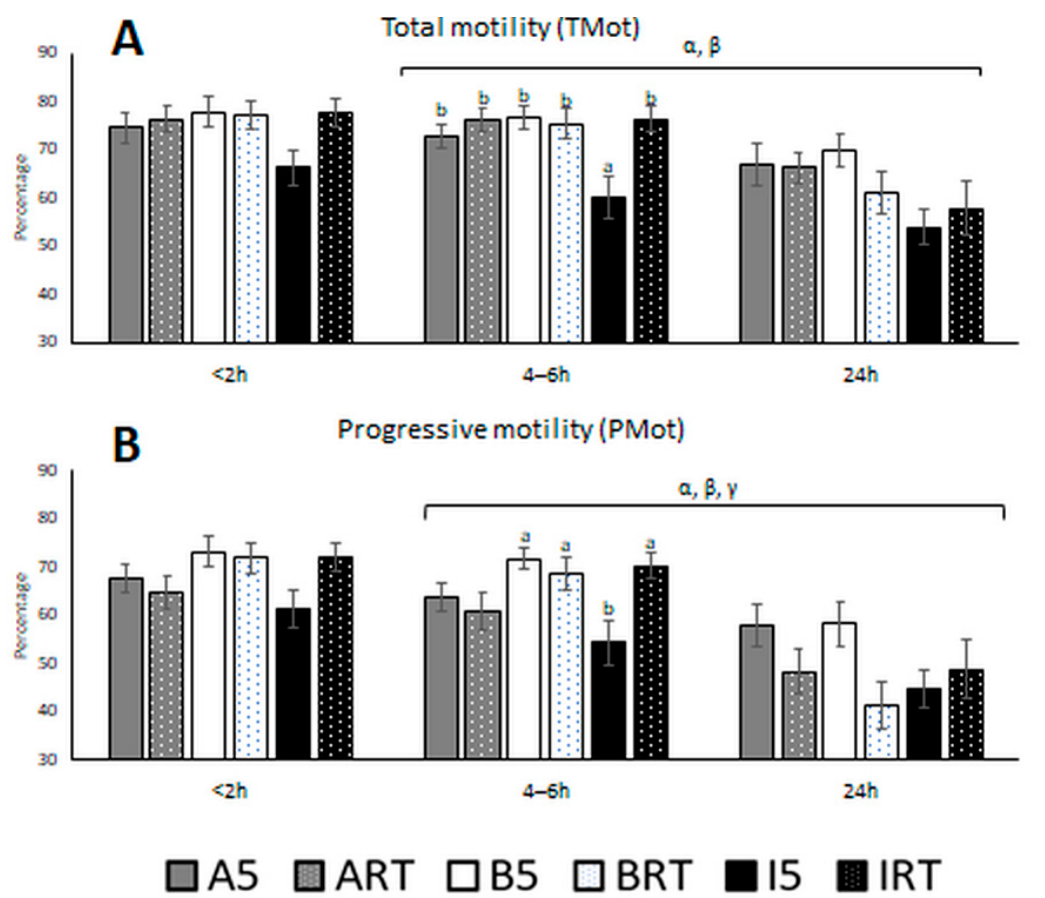
Figure 3. ( A ) Bull sperm total motility (percentage) and ( B ) progressive motility (percentage) after three storage durations in the presence of three semen extenders at two holding temperatures. Aliquot abbreviations: A: AndroMed ® ; B: BIOXcell ® ; I: INRA96 ® ; RT: room temperature; 5: refrigeration at 5 °C. Factors abbreviations: t: time; Temp: temperature; Ex: extender; α : interaction temperature by extender; β : interaction temperature by time; γ : interaction extender by time; δ : interaction temperature by extender by time. Bars with different letters denote significantly different values ( p < 0.05) among the six aliquots of the three extenders by two holding temperatures at each fixed time window (ANOVA). Bars without letters were not significantly different. Square bracket over the bars highlights a significant effect ( p < 0.05; from generalized linear mixed model analyses) of the factor or factor interactions by time. The bracket covers the time window where the effect is significant (from <2 to 4–6 h, from 4–6 h to 24 h, or from <2 to 24